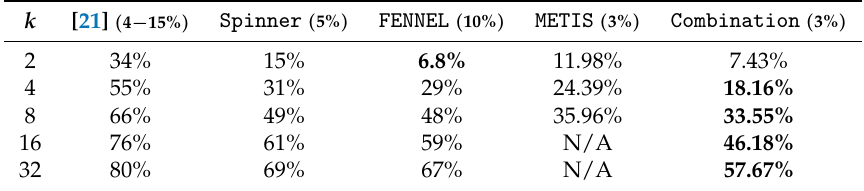
Table 3. Comparison to prior work on Twitter . The main entries are the ratio of edges cut by the clustering over the total number of edges in the graph. The number of clusters is denoted by k . Numbers in parentheses denote the permissible imbalance for each algorithm (Best results in each row are typeset in bold for easier spotting).